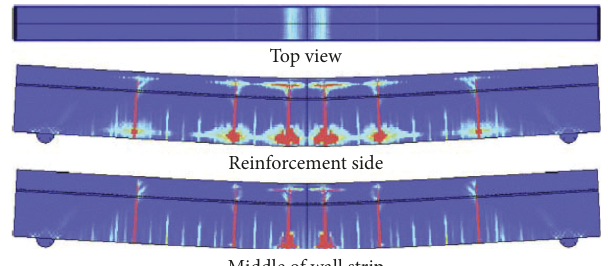
Figure 14: Damage in RC wall strip loaded with only blast load [3].